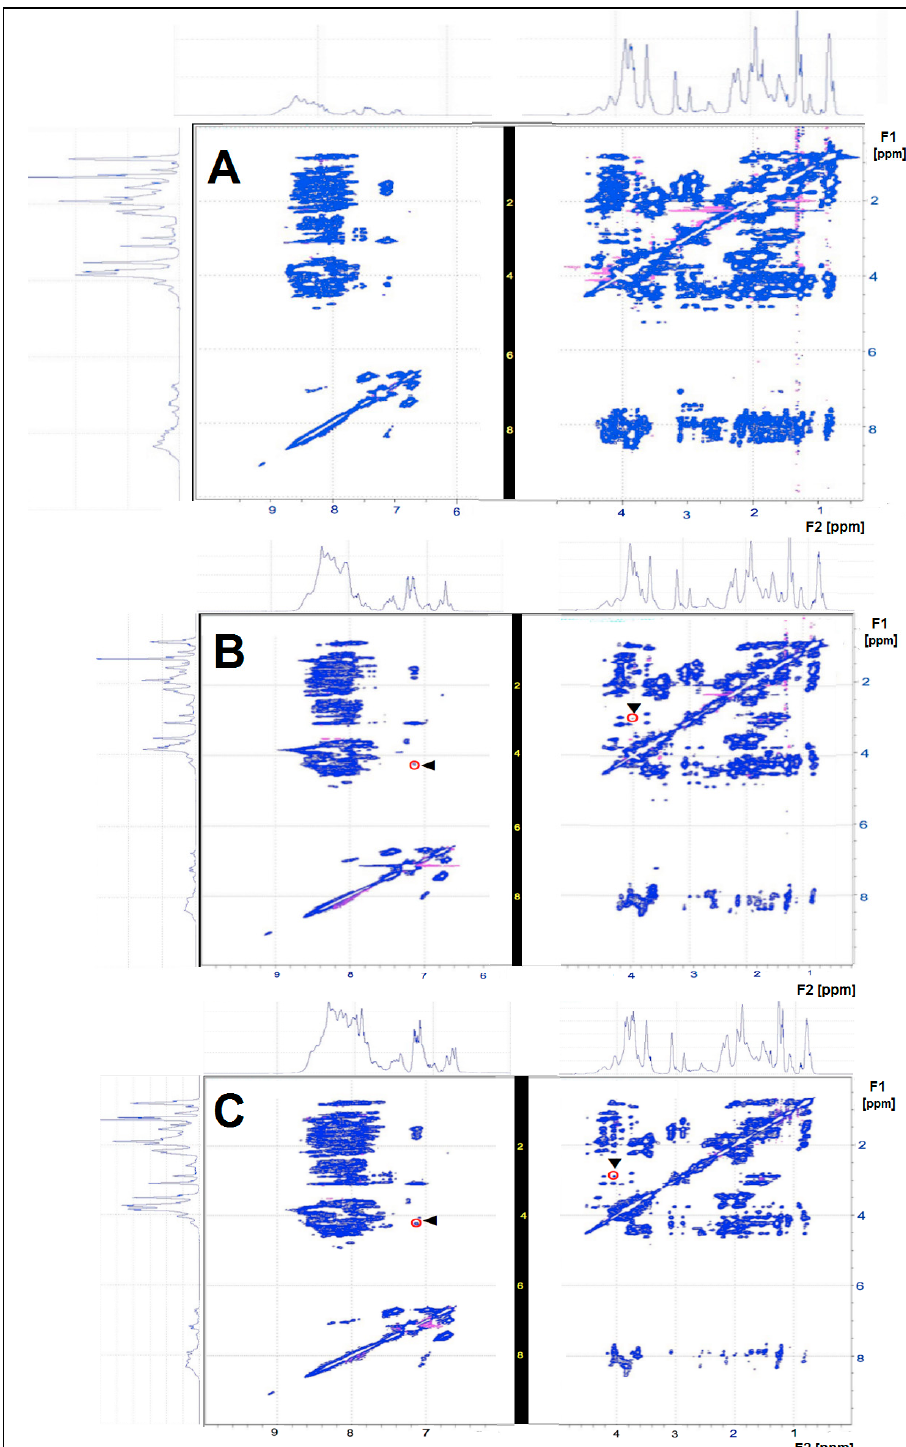
Figure 2. NMR-TOCSY spectra of the three CHs tested. The TOCSY spectra show characteristic signal alterations that can be used to discriminate the three CHs: ( A ) Mobiforte ® ; ( B ) Peptan ® F 5000; and ( C ) Peptan ® F 2000. Two cross peaks (at 4.3/7.4 ppm and at 3.0/4.0 ppm) in the TOCSY spectra of Peptan ® F 5000 and Peptan ® F 2000 are highlighted by an arrowhead and red circle. Cross peaks are all signal spots that occur below and above the diagonal line that represents the basic one-dimensional spectrum. The cross peaks below and above the diagonal line occur symmetrically and indicate which protons are coupled, based on their F1 and F2 ppm values.